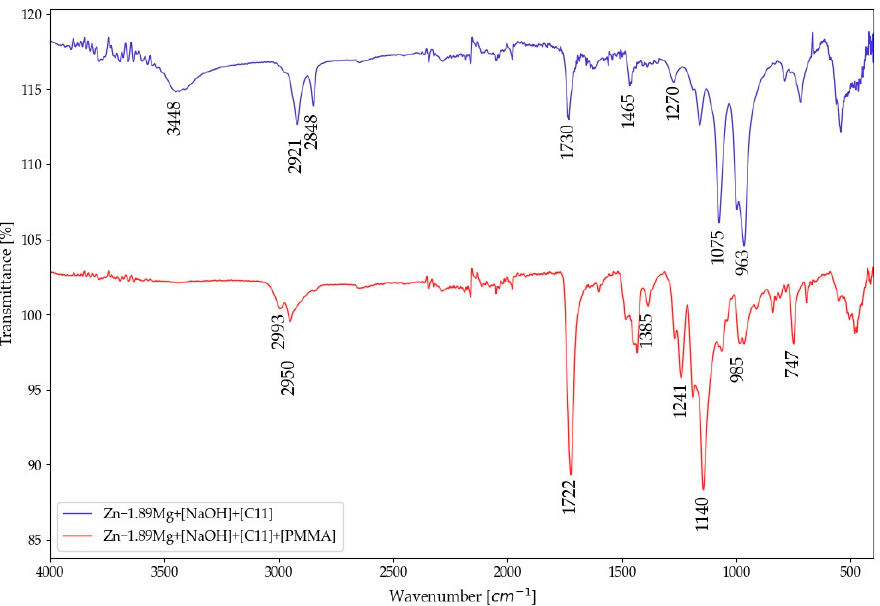
Figure 4. FTIR spectra of initiator-functionalized and -polymerised PMMA on the surface of the Zn- 1.89Mg.